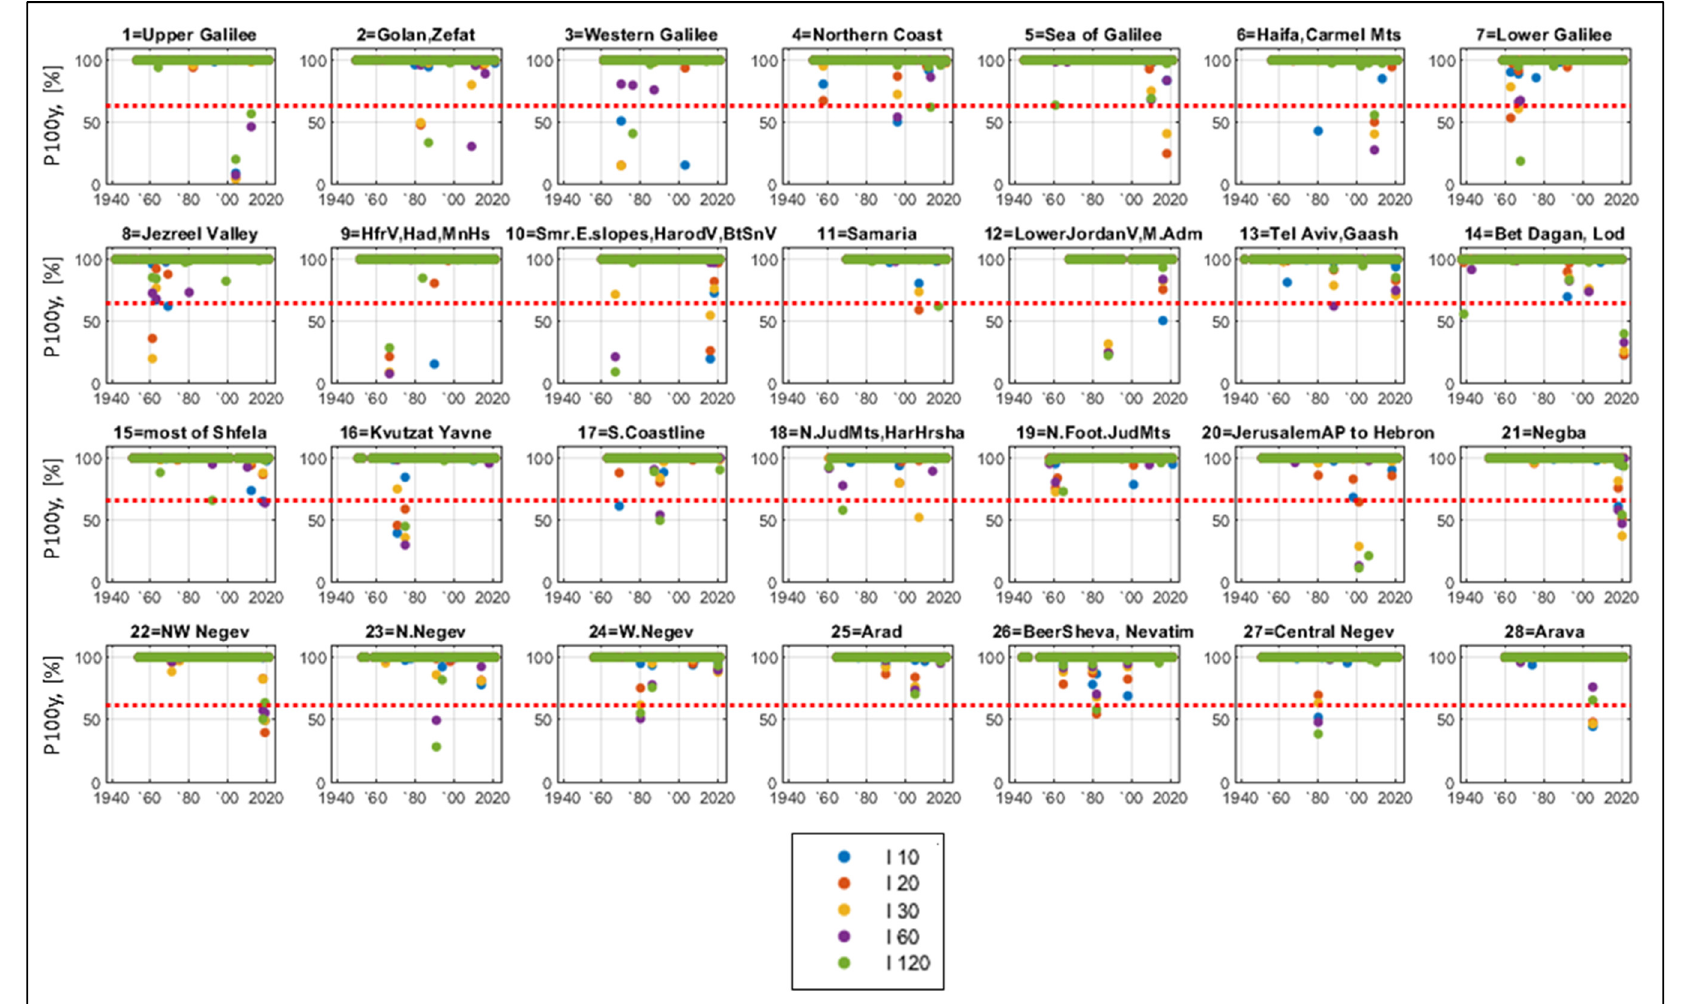
Figure 7. The 100-year exceedance probabilities. Red lines denote P 100y = 63% below which all points correspond to the short-interval rainfall intensities with return periods longer than 100 years. All the 100-year probabilities were calculated using Formula (4c) after substitutions: P 100y = 1 − (1 − 1/ T )100.